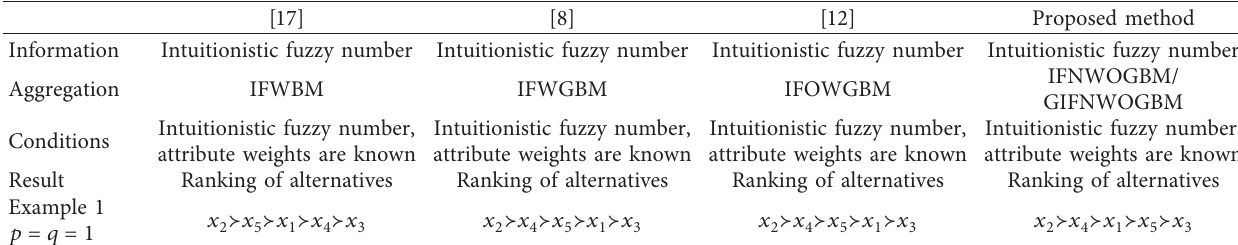
Table 5: Comparison with other